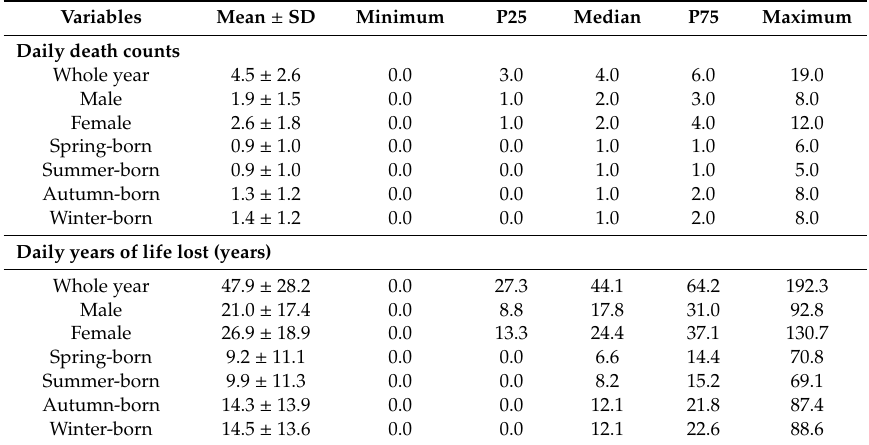
Table 2. Daily number of deaths and years of life lost from hypertension in the elderly individuals born in di ff erent seasons in Ningbo, China, from 2013 to 2016.